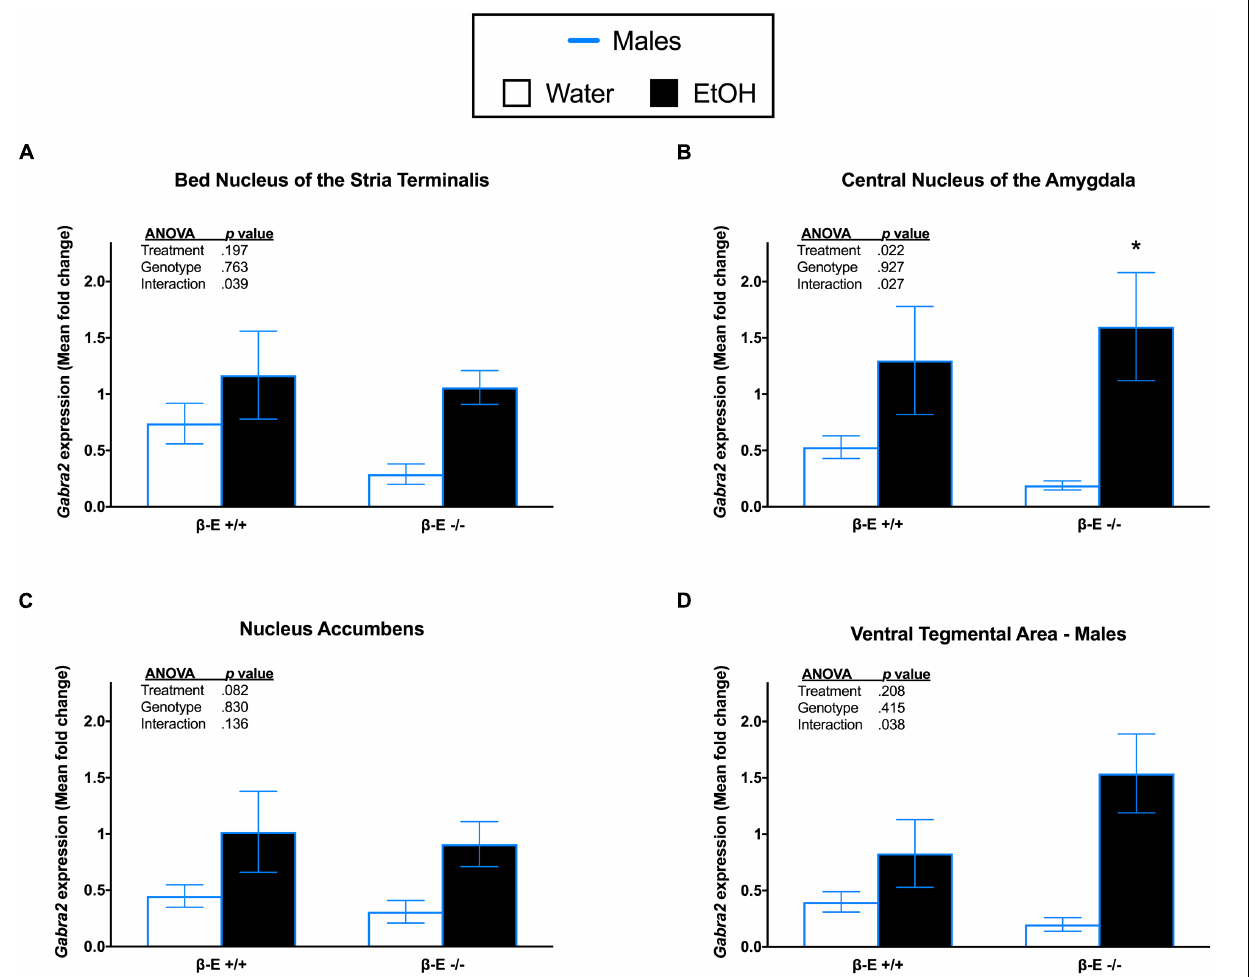
FIGURE 3 | Effects of ethanol on Gabra2 gene expression in stress- and reward-related brains regions of β E +/+ and β E –/– male mice. Gabra2 mRNA expression following binge-like consumption of either EtOH and water or water only in the DID paradigm. Two-way ANOVAs were used to examine the main and interaction effects of genotype ( β E +/+, β E –/–) and treatment (EtOH drinker, water drinkers) in each brain region, results of which are depicted within each graph. (A) In the BNST, there was a significant interaction, but post hoc analysis did not reveal any significant differences between groups. (B) In the CeA, post hoc analysis indicated that binge-like EtOH consumption increased Gabra2 expression in β E –/– males. (C) In the NAc, there was a significant interaction, but post hoc analysis revealed no significant differences between groups. (D) Similar to the NAc, in the VTA there was a significant interaction, but post hoc analysis revealed no significant differences between groups. ∗ p < 0.05 compared with the water group within the same genotype. Data are presented as means ± SEM; Bonferroni correction for multiple